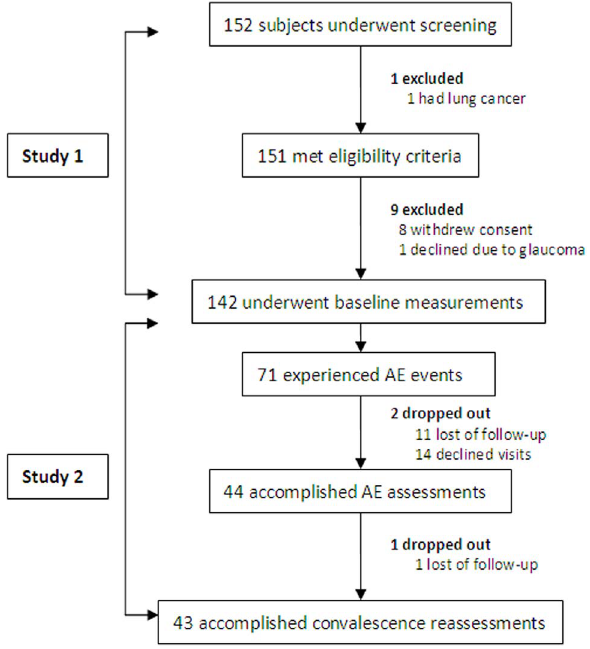
Figure 1. Subject enrollment flowchart. Of 151 patients underwent screening, 151 met eligibility criteria and 142 were included for analysis of study 1. Of these patients, 71 reported AEs, and finally 43 patients accomplished convalescence measurements. The data derived from 142 patients who underwent baseline measurements were analyzed for study 1 and 44 patients who accomplished assessments of acute exacerbations for study 2, respectively.